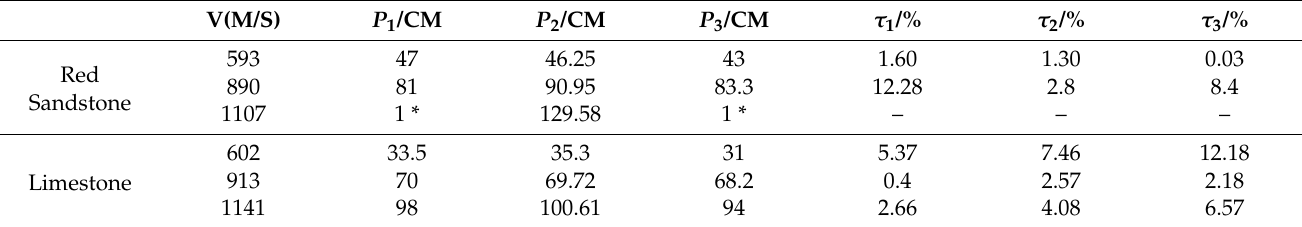
Table 7. Red sandstone and limestone penetration depth data.